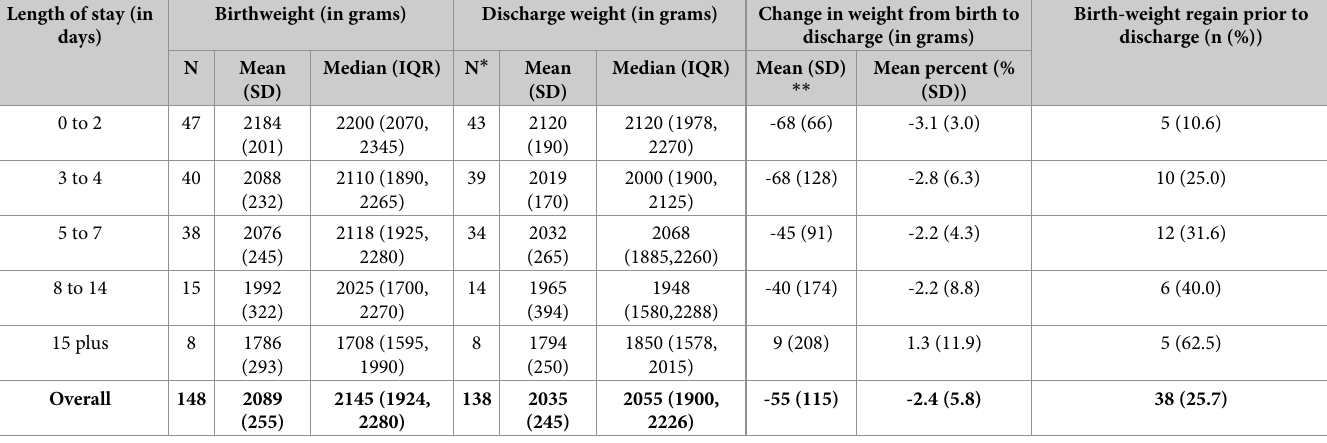
Table 5. Change in weight (grams) from birth to discharge by length of stay for 148 moderately low birthweight infants in 12 facilities in India, Malawi, and Tanzania. Length of stay (in